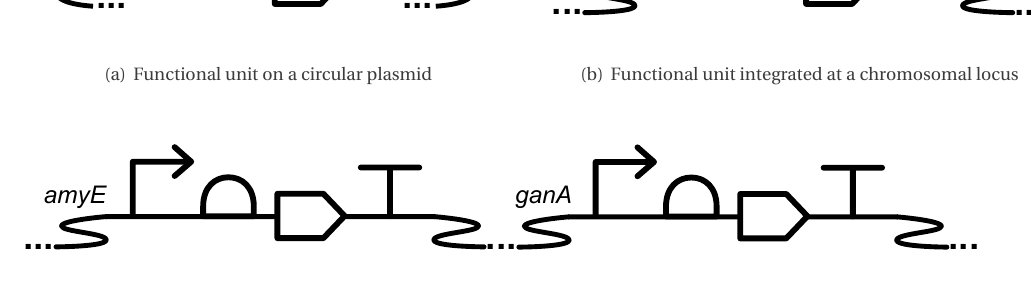
Figure 8: Examples of RECOMMENDED indication of genomic